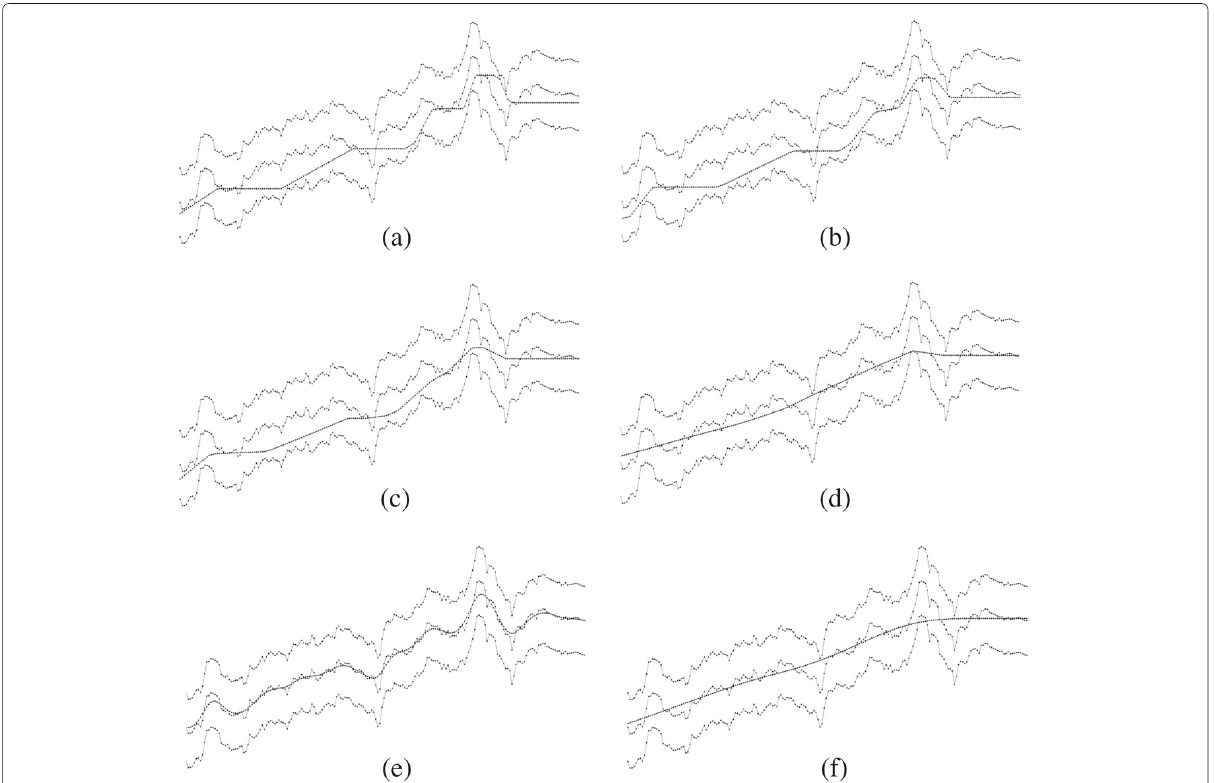
Fig. 13 Simulation results of a video including dynamic camera motion. a P 2,20% ( K = 2, proposed), b P 5,20% ( K = 5, proposed), c P 10,20% ( K = 10, proposed), d P 60,20% ( K = 60, proposed), e LPF 10 ( K = 10, low-pass filter), and f LPF 60 ( K = 60, low-pass filter). Weights for the proposed algorithm are set at (0.01, 0.01, 10). Image margin is set at